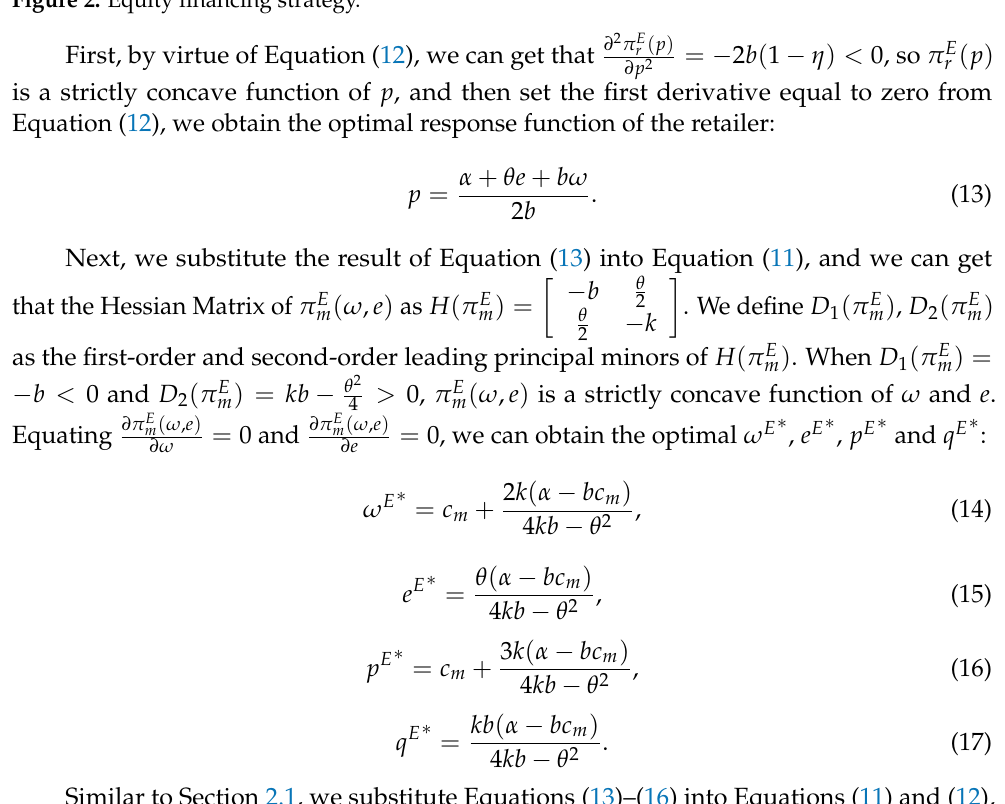
Figure 2. Equity financing